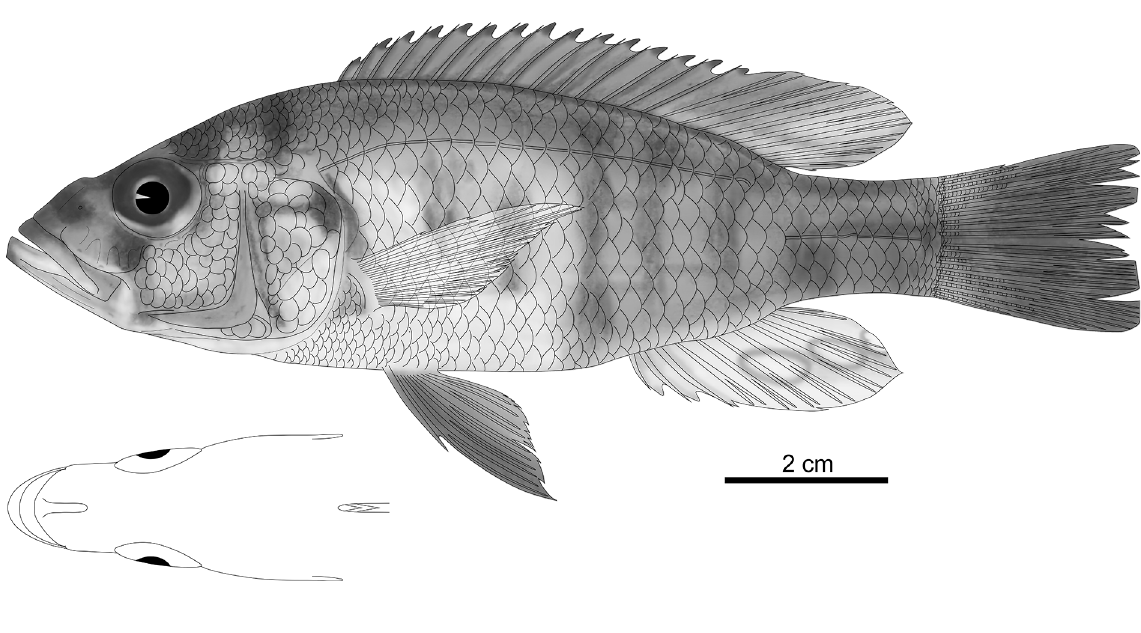
Fig. 29. Haplochromis curvidens sp. nov., holotype, ♂, 112.0 mm SL (RMCA 2016.035.P.0219). Drawn by N.